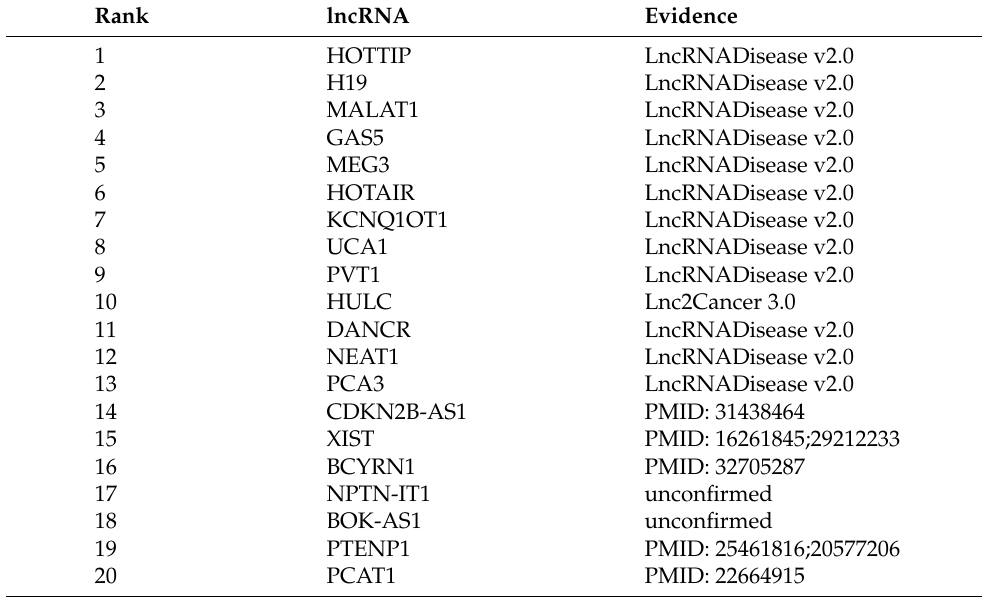
Table 2. Top 20 identified lncRNAs for prostate cancer.